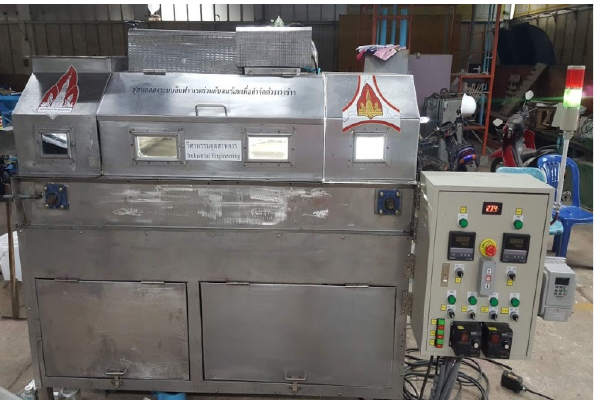
Fig.1 An example of the machine developed by the research team